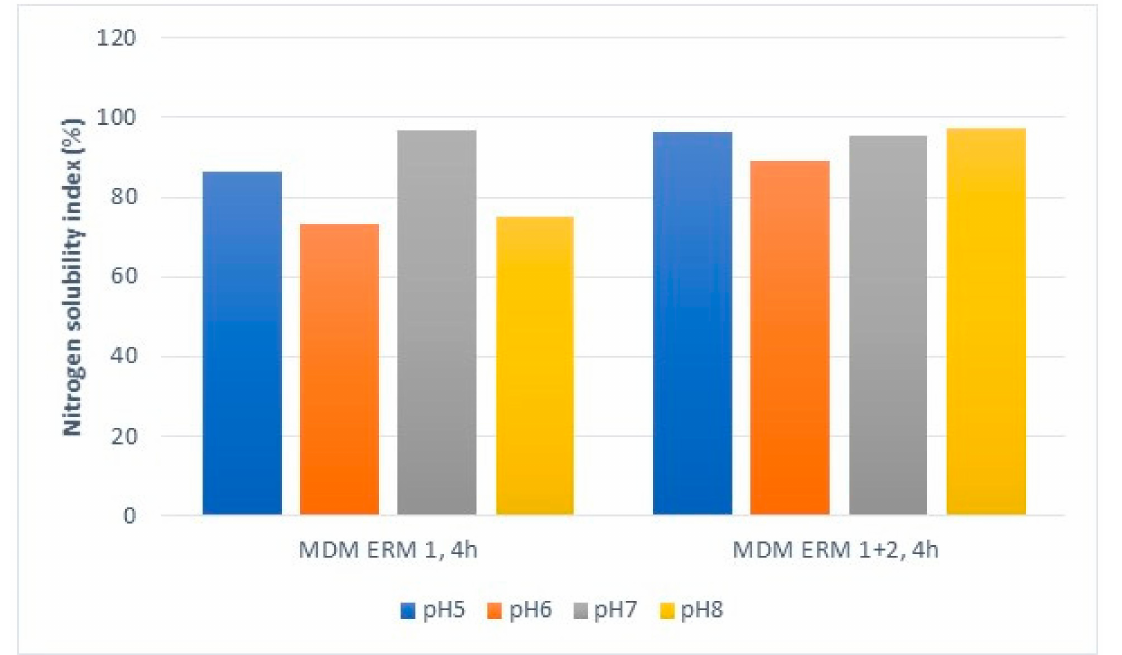
Figure 2. Nitrogen solubility index of chicken MDCM protein fractions obtained with ERM1 or ERM1 + 2 after 4 h